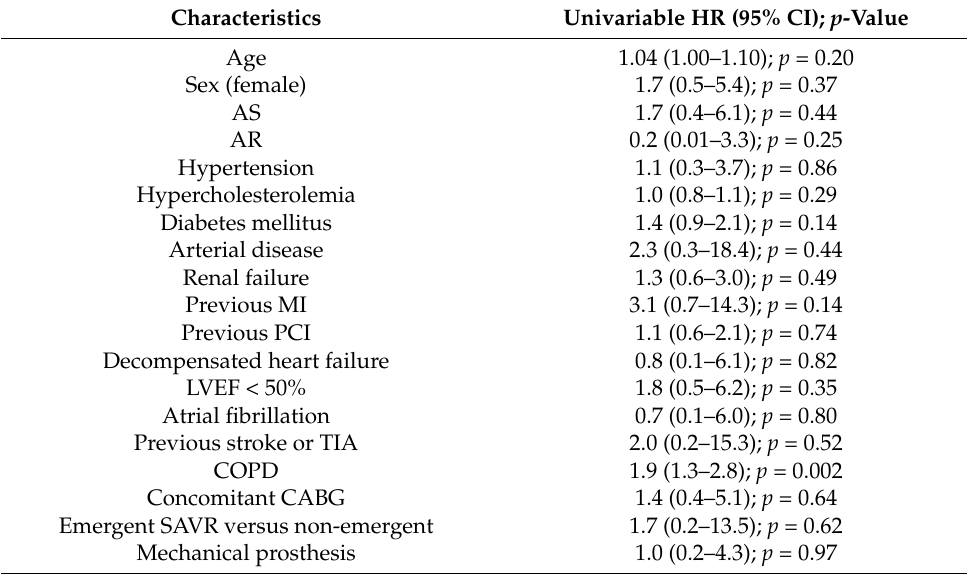
Table 2. Predictors of survival after SAVR with concomitant aortic surgery.